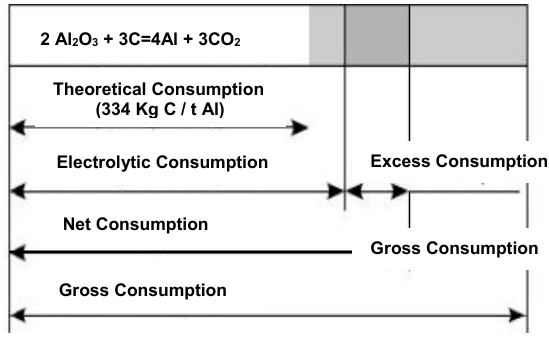
Figure 4. Carbon consumption.